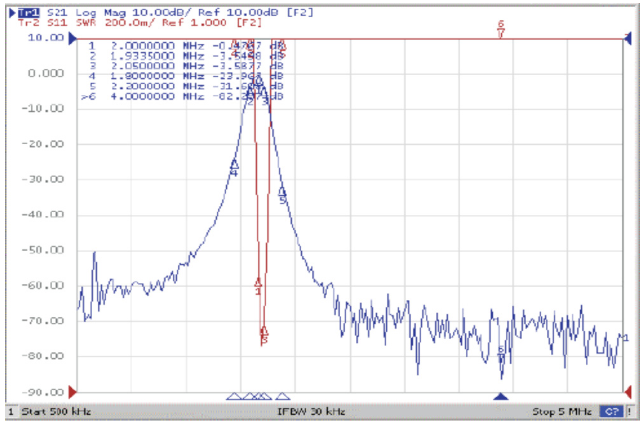
Figure 3. Frequency response of the narrowband tracking